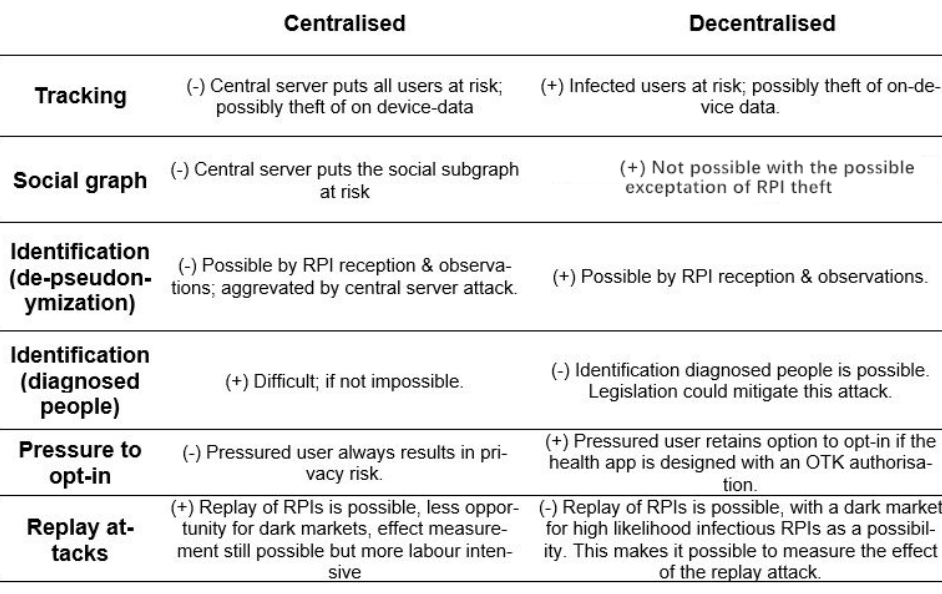
Figure 1. Overview of privacy and security